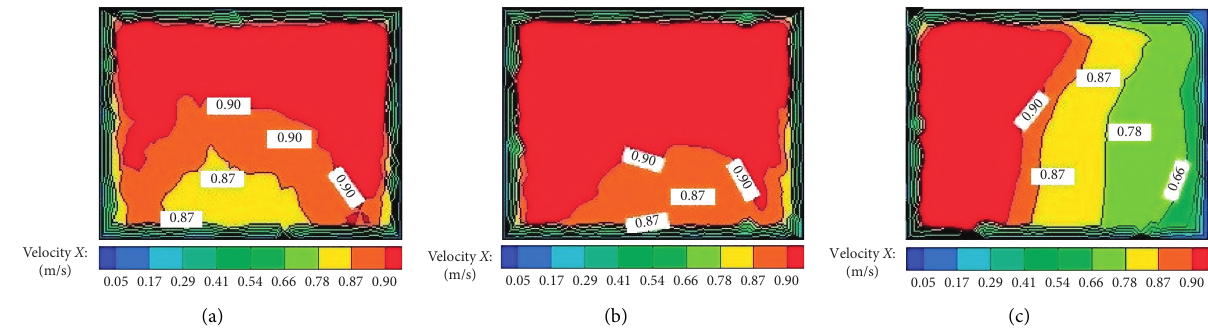
Figure 8: 1-1 plane velocity cloud diagram with 45 ° lateral angle (unit: m/s). (a) 3# passage. (b) 2# passage. (c) 1# passage.